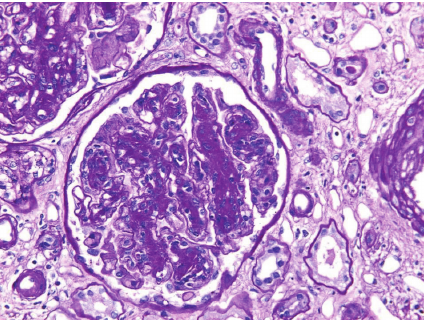
Figure 2: Transmission electron microscope photograph showing ultrastructural density along the GBM. ( ×